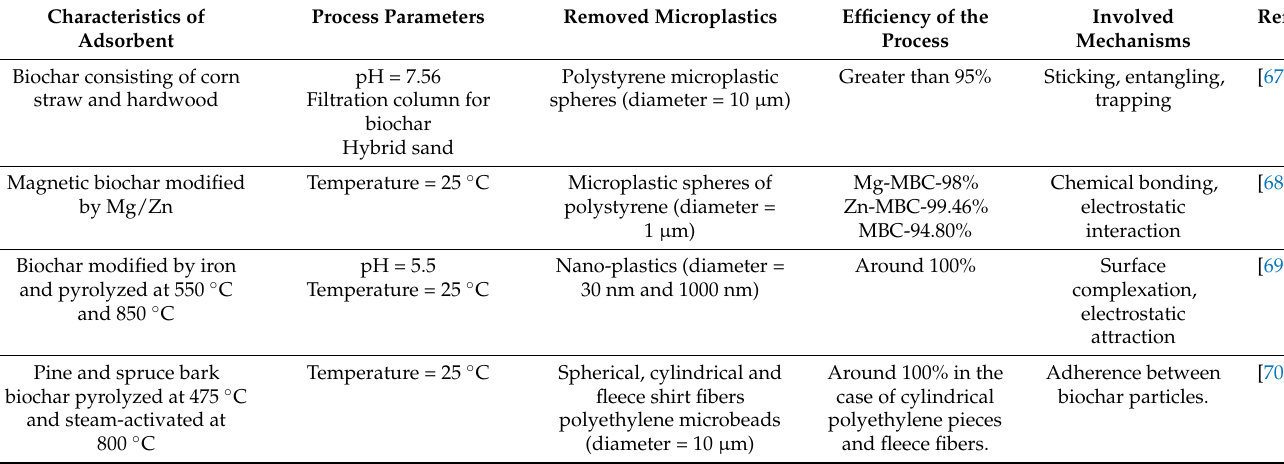
Table 2. Summary of the studies on microplastic removal using